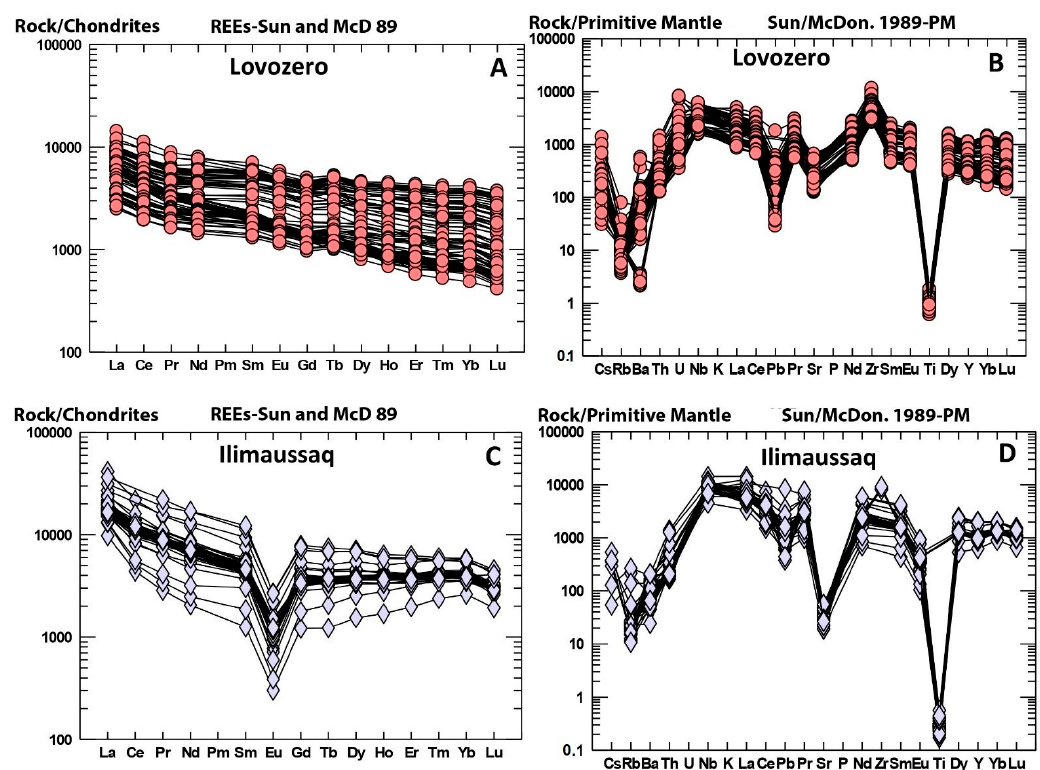
Minerals 2021 , 11 , x FOR PEER REVIEW Figure 3. ( A ) REE Lovozero; ( B ) spidergram Lovozero; ( C ) REE Ilímaussaq; ( D ) spidergram Ilímaussaq [3,8,23]. Figure 3. ( A ) REE Lovozero; ( B ) spidergram Lovozero; ( C ) REE Il í maussaq; ( D ) spidergram Il í maussaq [3,8,23].